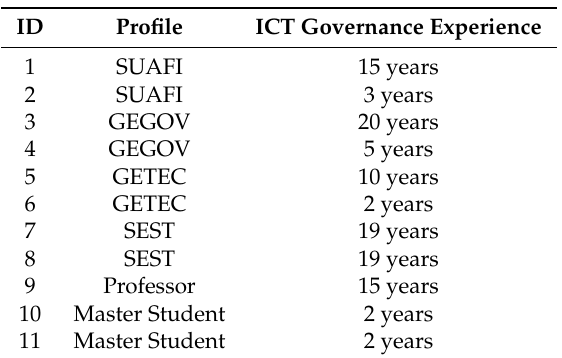
Table 2. Profile of the case study